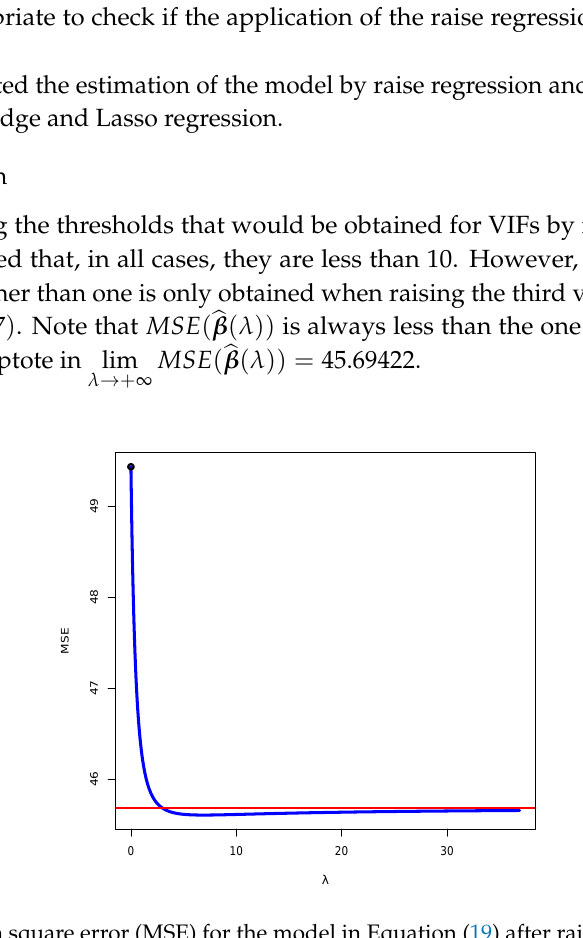
Figure 3. Mean square error (MSE) for the model in Equation (19) after raising third